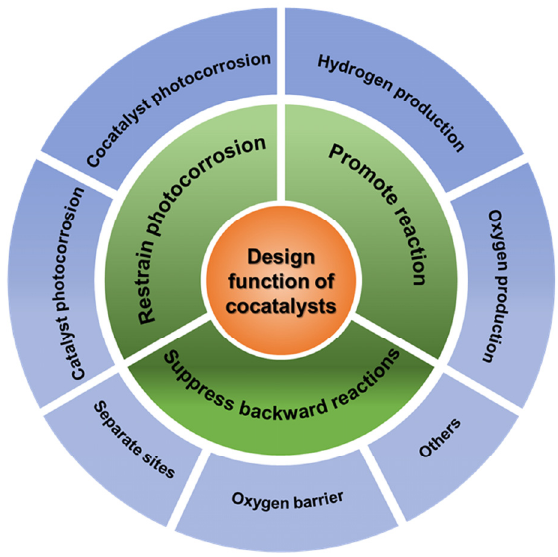
Figure 3. Various roles of cocatalyst for POWS.